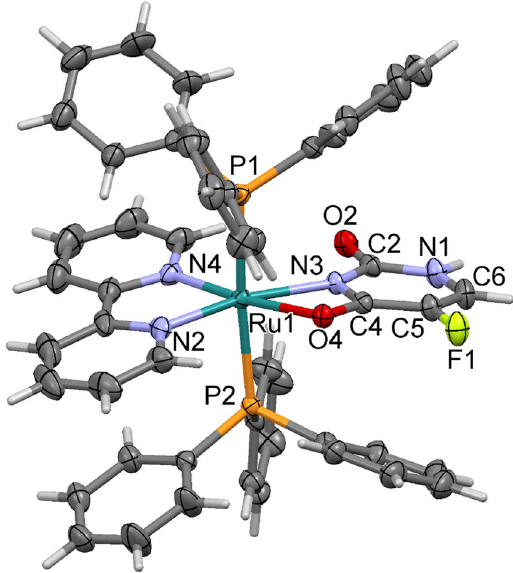
Figure 2. Crystal structure of the complex [Ru(5-FU)(PPh 3 ) 2 (bipy)]PF 6 with main atoms labelled and ellipsoids at 30% probability. For clarity, the PF 6 − was